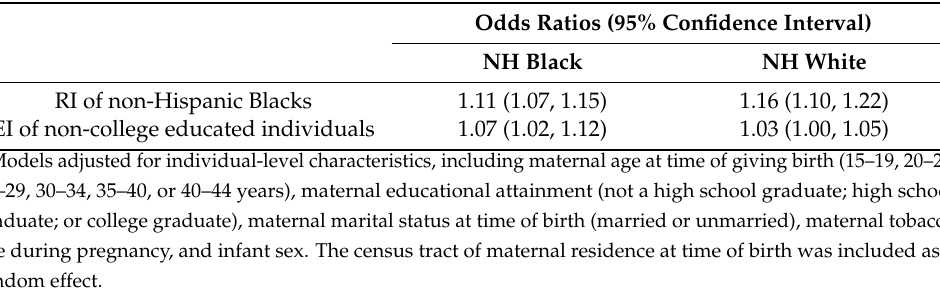
Table 3. Associations between preterm birth and racial isolation and educational isolation a